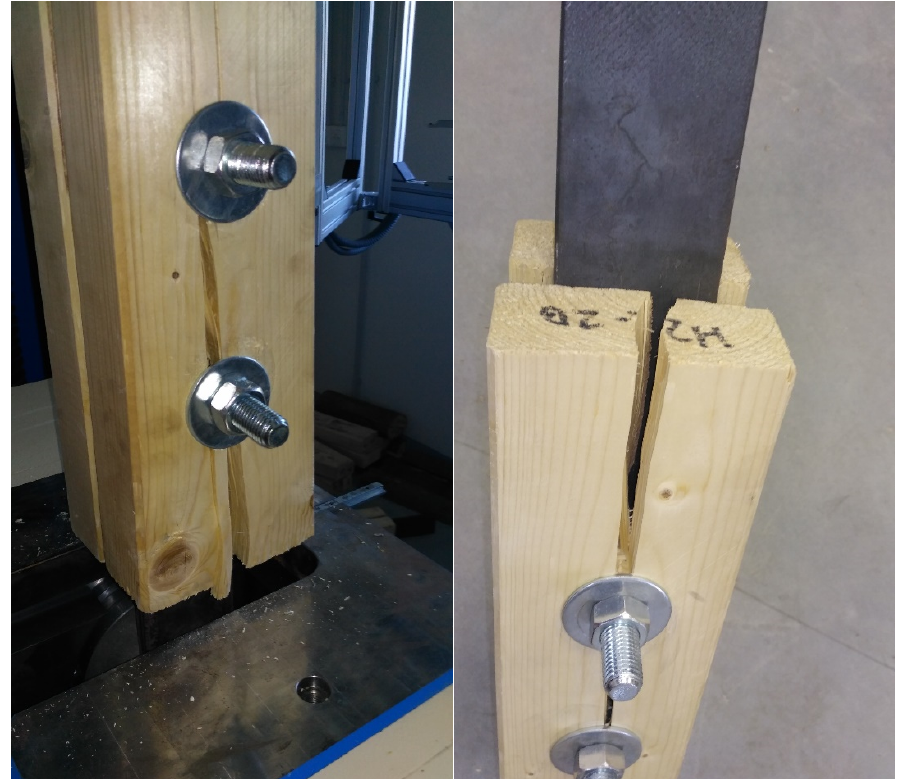
Figure 19. Specimens of squared timber connections after failure.